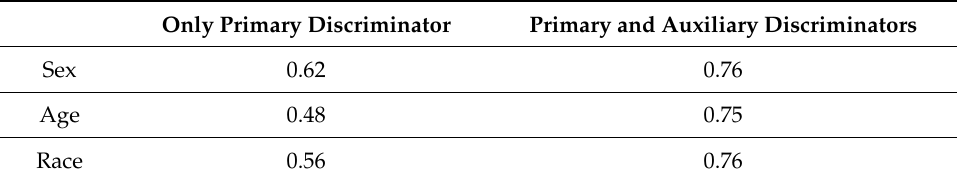
Figure 10. Ablation study: comparison of the results with or without auxiliary discriminator. Table 6. Comparison of recognition ratios for the ablation